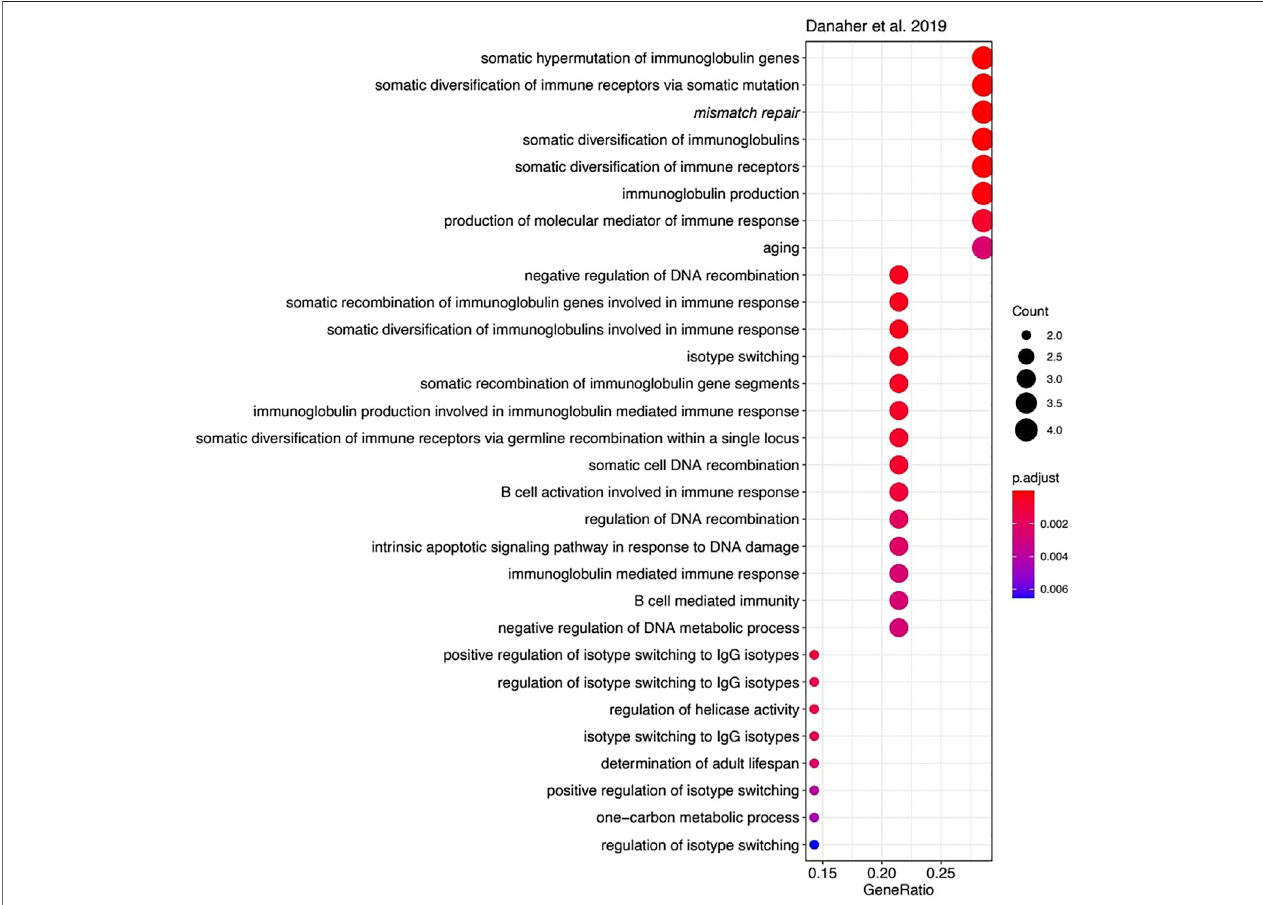
FIGURE 5 | Biological process GO terms for genes included in Danaher signature. Visualized using R package enrichplot (http://bioconductor.org/packages/ release/bioc/html/enrichplot.html). All terms passed Benjamini – Hochberg adjusted p -value threshold of 0.05.